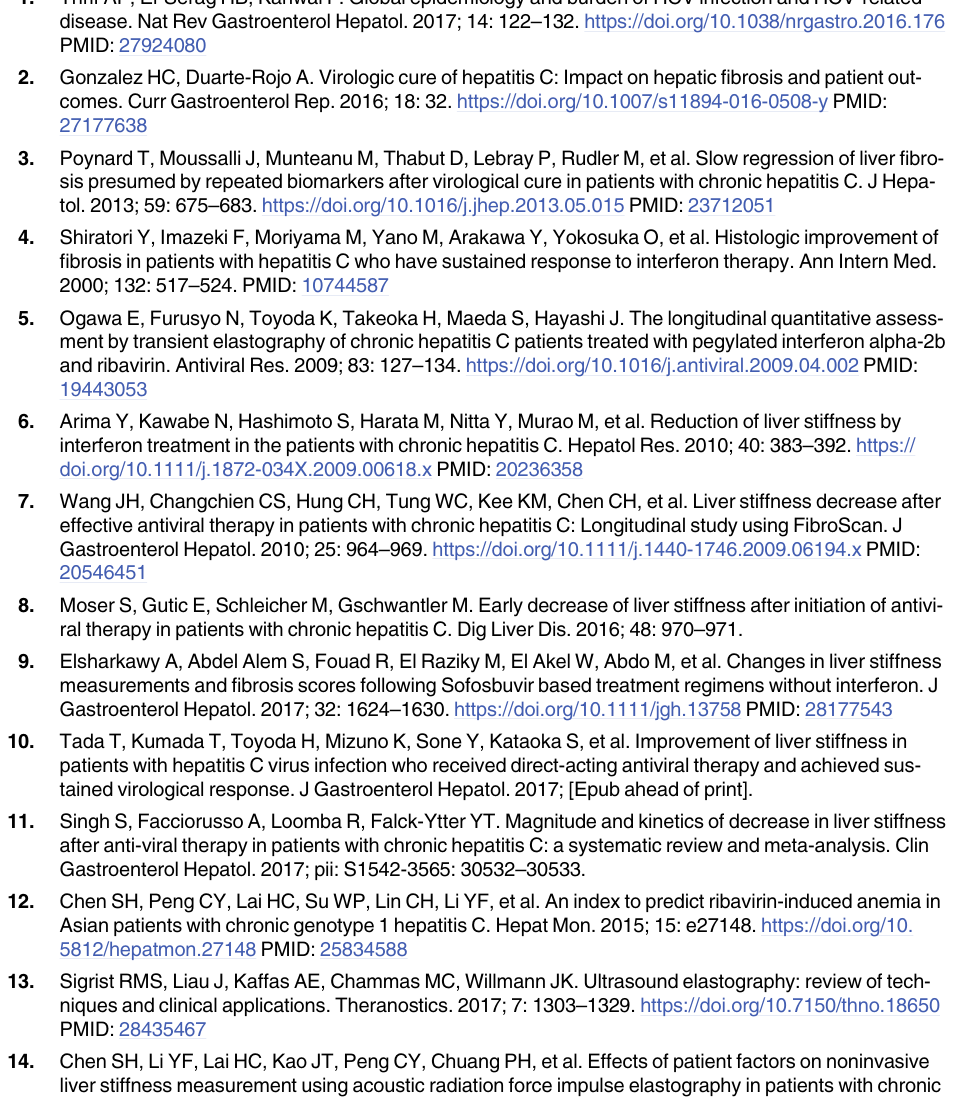
S8 Table. Multiple linear regression for liver stiffness decline in patients with advanced fibrosis and cirrhosis (n =